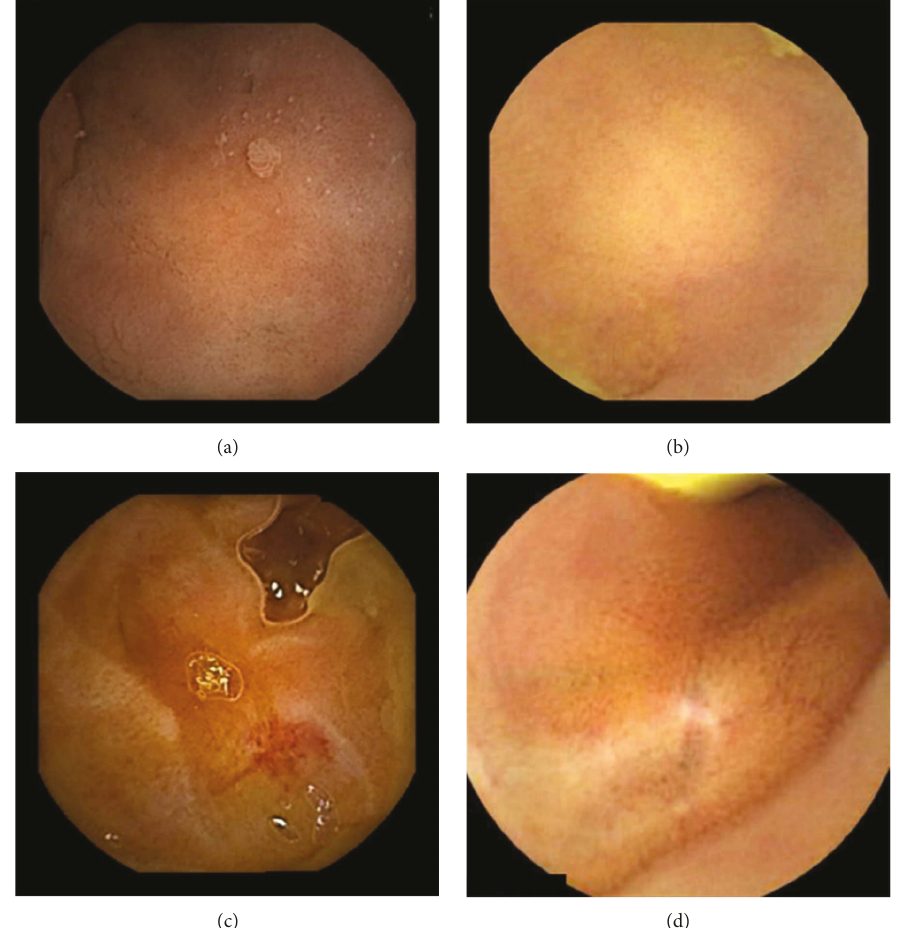
Figure 2: Examples of discordant cases. In patient 5, PillCam SB3 revealed a polypoid mass in the distal ileum (a), while MiroCam was not able to capture the lesion (b). In patient 6, the PillCam SB3 detected angiodysplasia in the jejunum (c), while the MiroCam could not (d).